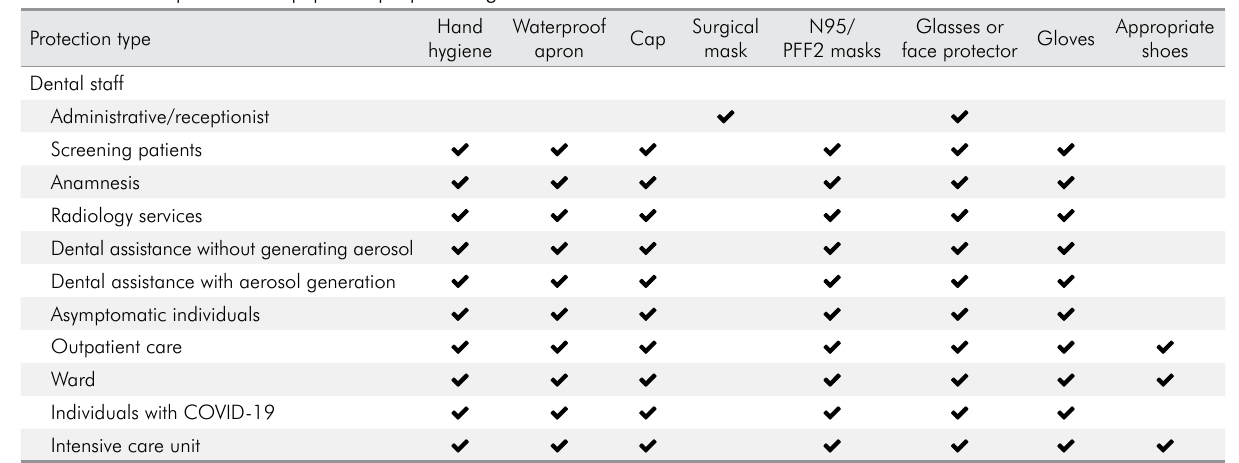
Table. Personal protective equipment proposed against